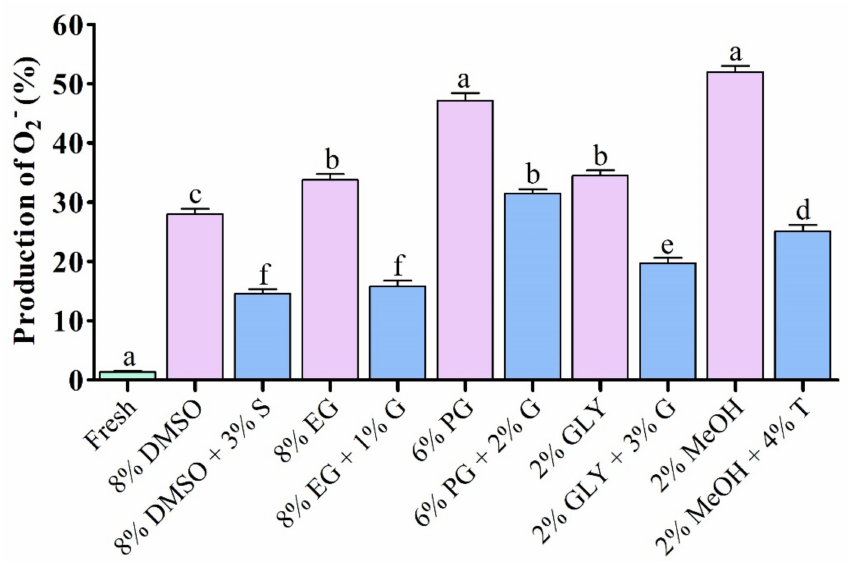
Figure 3. Superoxide anion production (O 2 •− ) in different types of post-thaw sperm. Results are presented as mean values ± standard deviation ( n = 10). DMSO: dimethyl sulfoxide, EG: ethylene glycol, PG: propylene glycol, GLY: glycerol, MeOH: methanol, S: sucrose, G: glucose, T: trehalose. Significantly different levels ( p < 0.05) are denoted by different